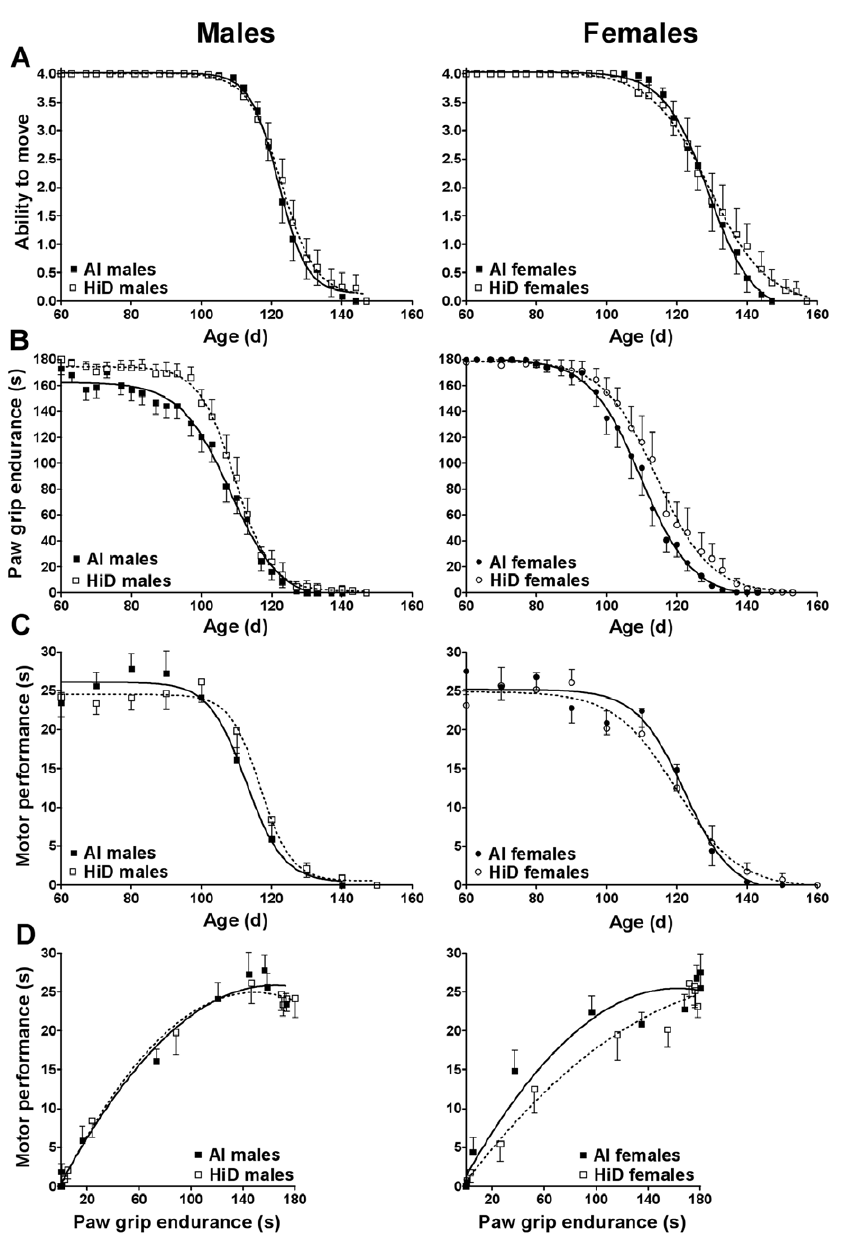
Figure 1. Functional outcomes over time and motor performance vs. paw grip endurance. A) Ability to move, B) paw grip endurance (s), N C) motor performance (s) and D) correlation between motor performance (s) and paw grip endurance (s) for 31 adequate intake (AI; 1 IU D 3 /g feed; & , 18 males; , 13 females) and 28 high (HiD; 50 IU D 3 /g feed; % , 15 males; # , 13 females) vitamin D 3 G93A mice. A and C) There were no significant differences between the diets for ability to move or motor performance. B) For paw grip endurance, HiD mice had a 12% greater score between age 60–141 d (P=0.015), a 9% greater score prior to disease onset (P=0.020) and a 37% greater score during disease progression (P=0.042) vs. AI mice. Differences were driven by a 13% greater score between age 60–141 d and prior to disease progression in HiD males (P=0.032 and P=0.024, respectively), and by a 43% greater score during disease progression in HiD females (P=0.095). D) Corrected for paw grip endurance, HiD females had a 19% lower motor performance vs. AI females (P=0.086). Data are means 6 SEM. doi:10.1371/journal.pone.0030243.g001 corresponding to an average vitamin D 3 intake of 3.37 IU/d Body weight (0.170 IU/g b.wt./d) (Figure S1A and S1B). HiD mice had an Body weight was not significantly different between the diets average absolute food intake of 3.11 6 0.05 g/d (162.1 6 3.3 mg/g (Table 2). AI mice had an average body weight of 20.2 6 0.4 g, b.wt./d), corresponding to an average vitamin D 3 intake of and HiD mice had an average body weight of 19.6 6 0.4 g 155.5 IU/d (8.11 IU/g b.wt./d). Males (3.33 6 0.05 g/d) con- (Figure S1C). sumed 8% more absolute food vs. females (3.15 6 0.05 g/d; P =0.014).